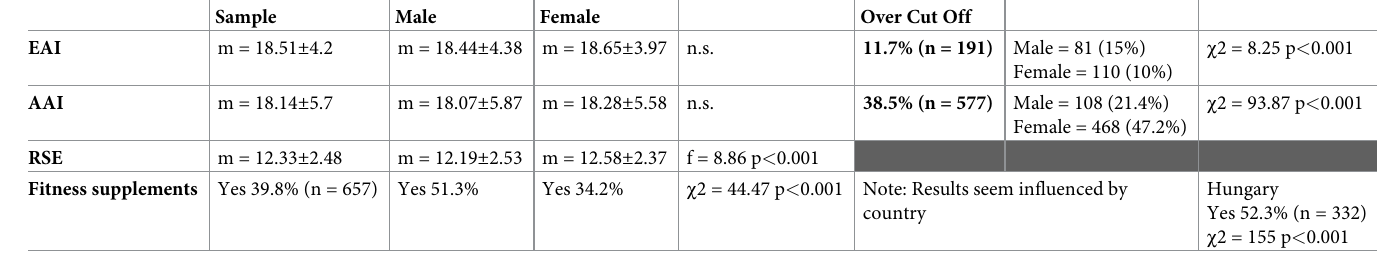
were also recorded on the Rosenberg Self-Esteem. As better highlighted in Table 3, the results were statistically different across the countries (p < 0.001) with the Netherlands and Hungary respectively, showing the highest levels in the Exercise Addiction Inventory and Appearance Anxiety Inventory (20.9% and 51.5% over the cut-off). A logistic regression model was used to predict the use of fitness products. The independent covariables used in this model were: age (linear variable); Rosenberg Self-Esteem scores (low self-esteem as a linear variable); EA (suggested by a score of 24 or above in the Exercise Addic- tion Inventory) and appearance anxiety (suggested by a score of 19 or above on the Appear- ance Anxiety Inventory, indicating a clinical risk for BDD). All the variables were tested in three models one for the entire sample and the other two according to gender. In all three Table 2. Exercise Addiction Inventory (EAI), Appearance Anxiety Inventory (AAI), Rosenberg Self-Esteem (RSE) scores and use of fitness supplements with specifi- cation of gender differences. Sample Male Female Over Cut